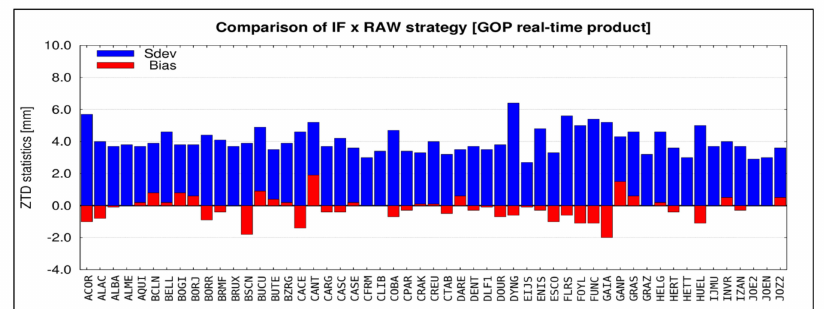
Figure 7. Statistics of the di ff erence between the ZTD estimated with IF and RAW models.